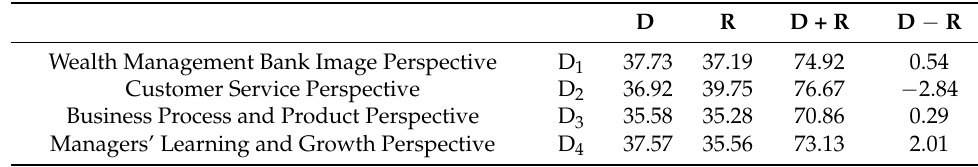
Table 2. Direct and indirect effects of four dimensions.